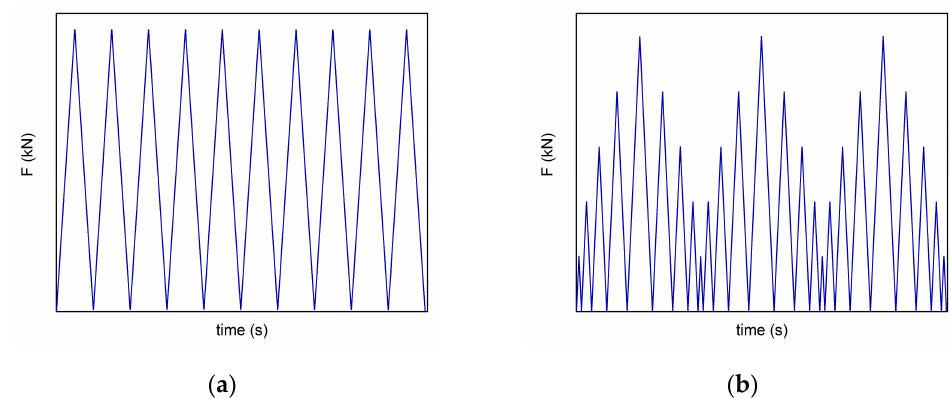
Figure 1. Loading regimes during a cyclic self-sensing test: ( a ) Measurement with constant force amplitude; ( b ) Measurement with variable force amplitude.